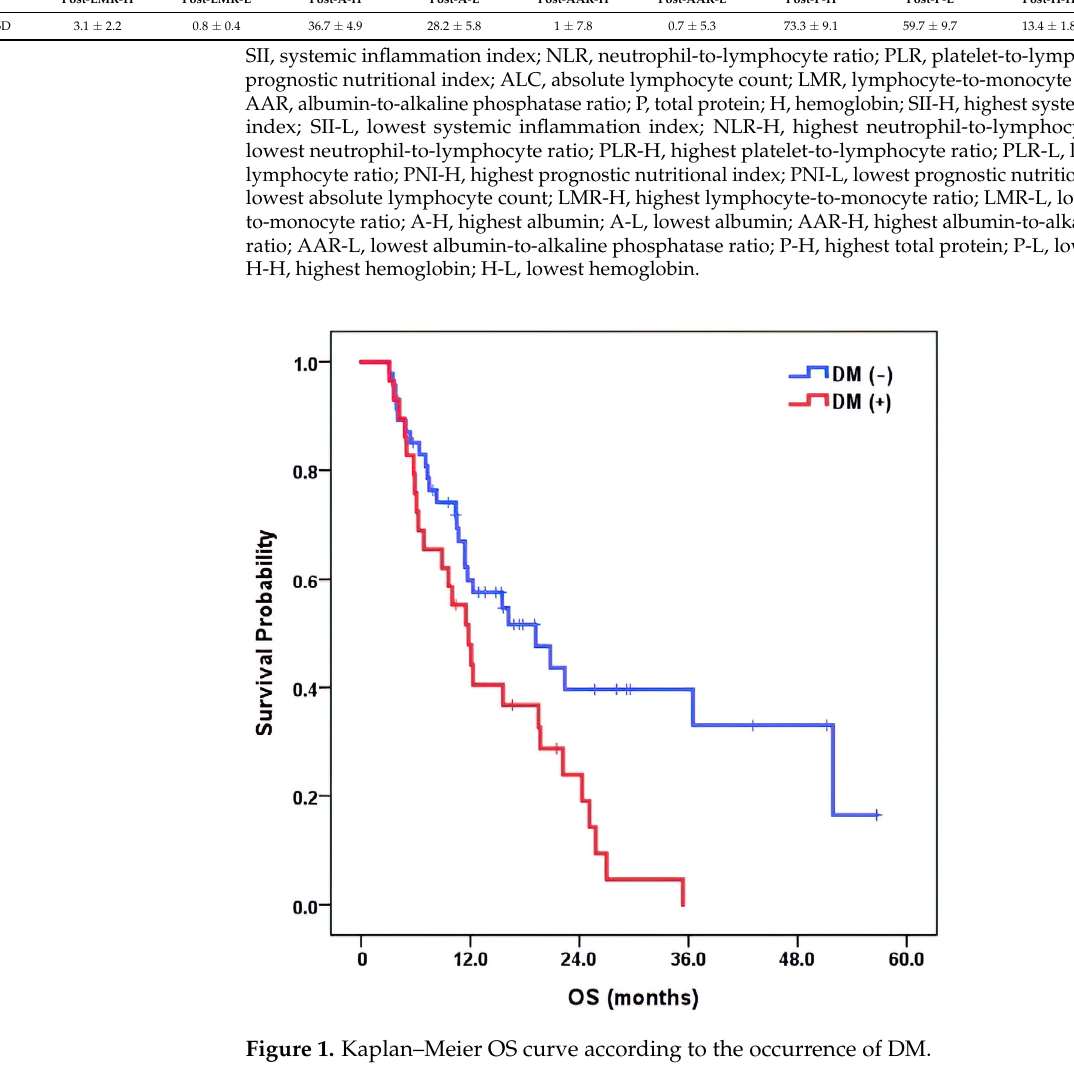
Table 4. Optimal cutoff points of variables for major study end points.